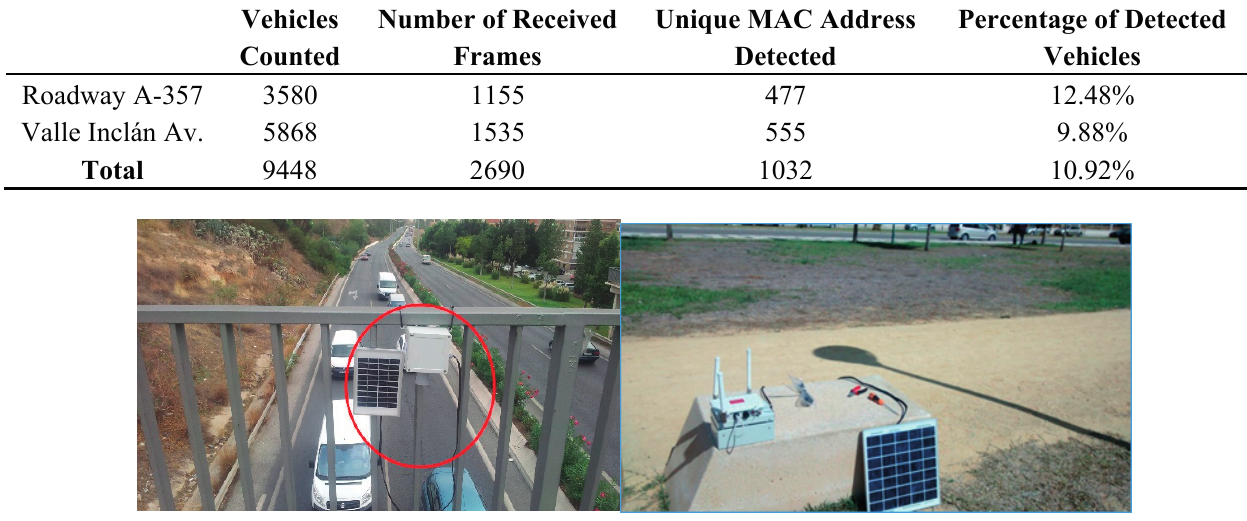
Figure 15. Different deployments for outdoor tests. ( a ) A-357 deployment test; ( b ) Valle-Inclán Av. deployment test. Table 3. Detected vehicles in Bluetooth tests.